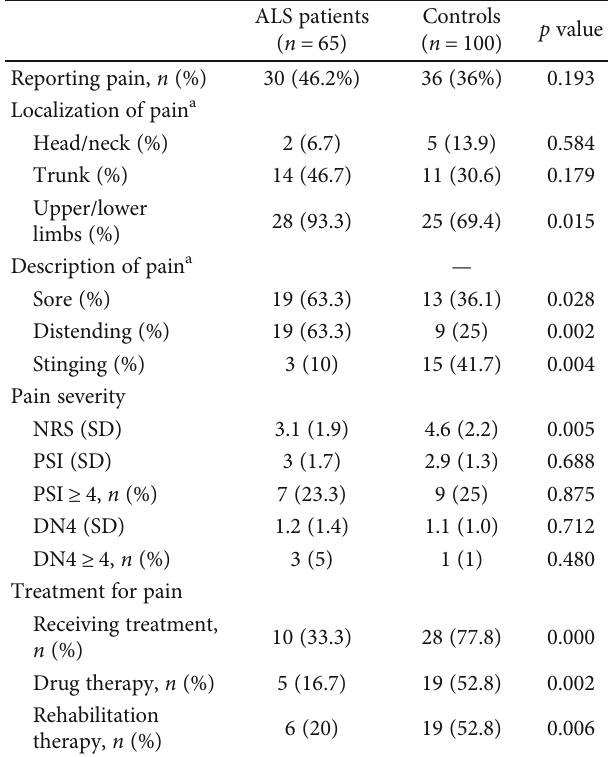
Table 2: Characteristics and therapy of pain in patients with ALS and